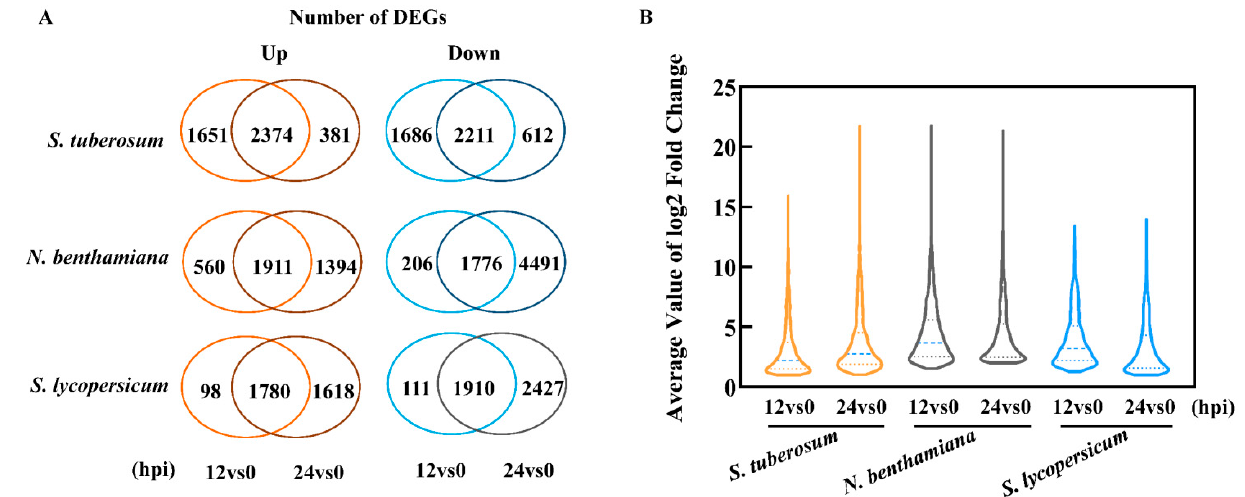
Figure 3. Different expressed genes induced by P. infestans among the TSHs. ( A ) Venn diagram representation of the host-specific up-regulated genes distribution at 12 and 24 hpi and the number of up-regulated and down-regulated DEGs induced by P. infestans in TSHs (DESeq2 padj ≤ 0.01, |log2 Fold Change| ≥ 1.0). The upregulated transcripts were shown in orange color, and the downregulated transcripts were shown in blue color. ( B ) The average value of log2 fold change of the host-specific up-regulated genes 12 and 24 hpi. The thick blue dotted line represented the median.